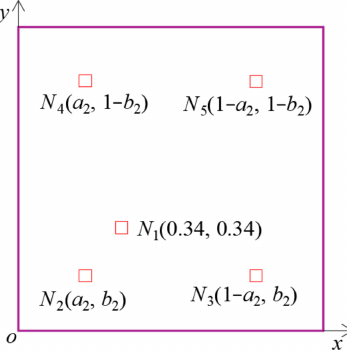
Figure 18. The layout case 2 of the five NESs.